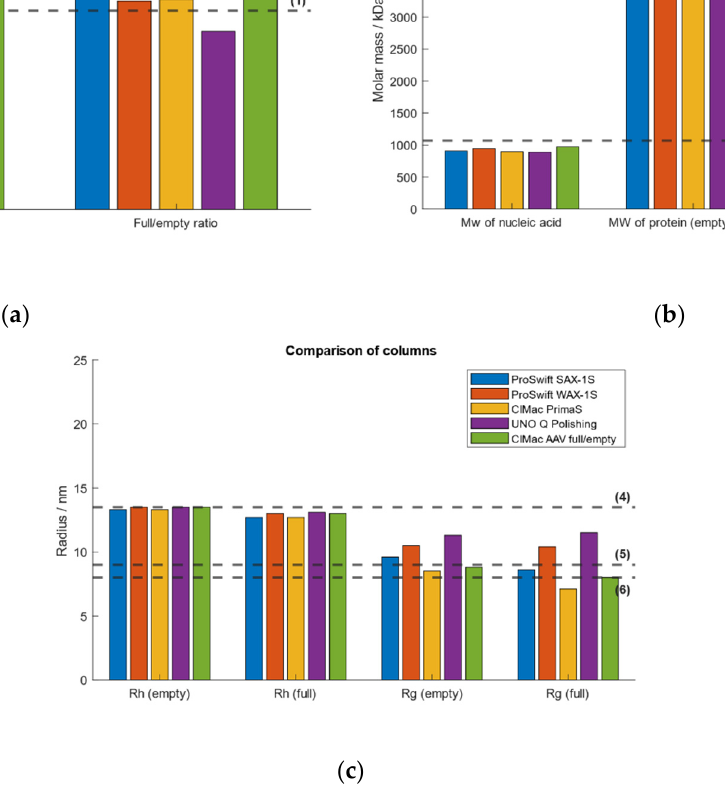
Figure 6. Evaluation of the method performance of the developed IEC-MALS assay using five different anion-exchange columns. The strong AEX columns ProSwift SAX-1S (blue), UNO Q Polishing (purple) and CIMac AAV full/empty (green) and the weak AEX columns ProSwift WAX-1S (orange) and CIMac PrimaS (yellow). Dashed lines (1)–(6) represent (a) the expected F/E ratio, (b) the absolute molar mass of the protein, the absolute molar mass of the encapsidated ssDNA, (c) the hydrodynamic radius, the radius of gyration of empty AAV capsids and the radius of gyration of filled AAV particles, respectively.